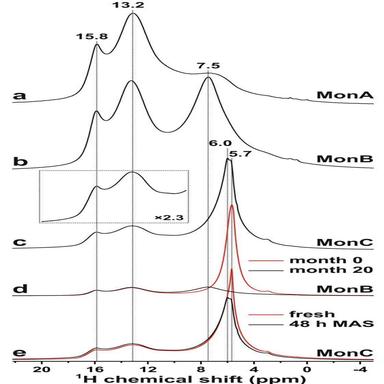
1 H NMR spectra acquired at 14.00 kHz MAS from powders of the (a) MonA, (b) MonB, and (c) MonC cements. As-prepared cements comprise large amounts of intergranular water. During months of storage in a desiccator, the cement powders continuously dehydrate, as illustrated by the NMR spectra in (d) that were recorded from a "fresh" powder of MonB (red trace) and after ≈20 months of storage (black trace). Similar dehydration effects are induced by the sample spinning during the NMR experimentation, as witnessed